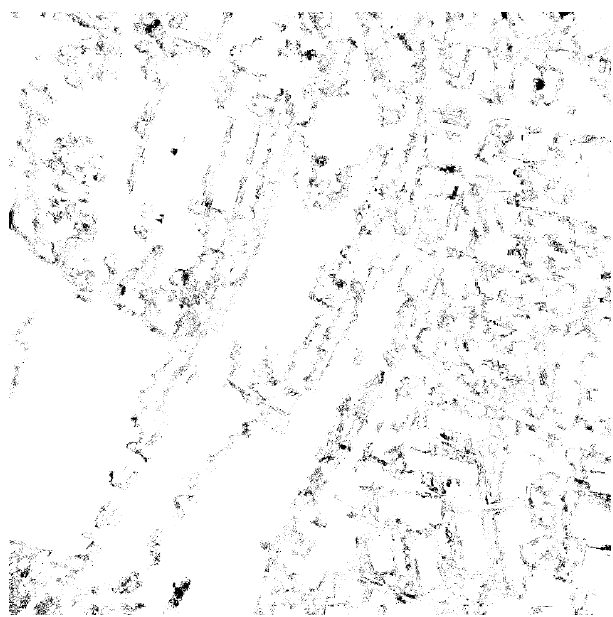
Figure 10. The di ff erence between the registration results of (Row − 1, Column − 1) and (Row + 0, Figure 10. The difference between the registration results of (Row − 1, Column − 1) and (Row + 0, Column + 0). Column +